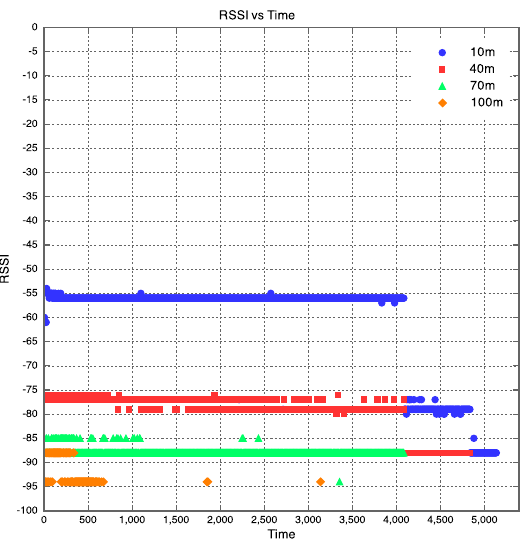
Figure 6. RSSI vs. Time for Experiment 1.